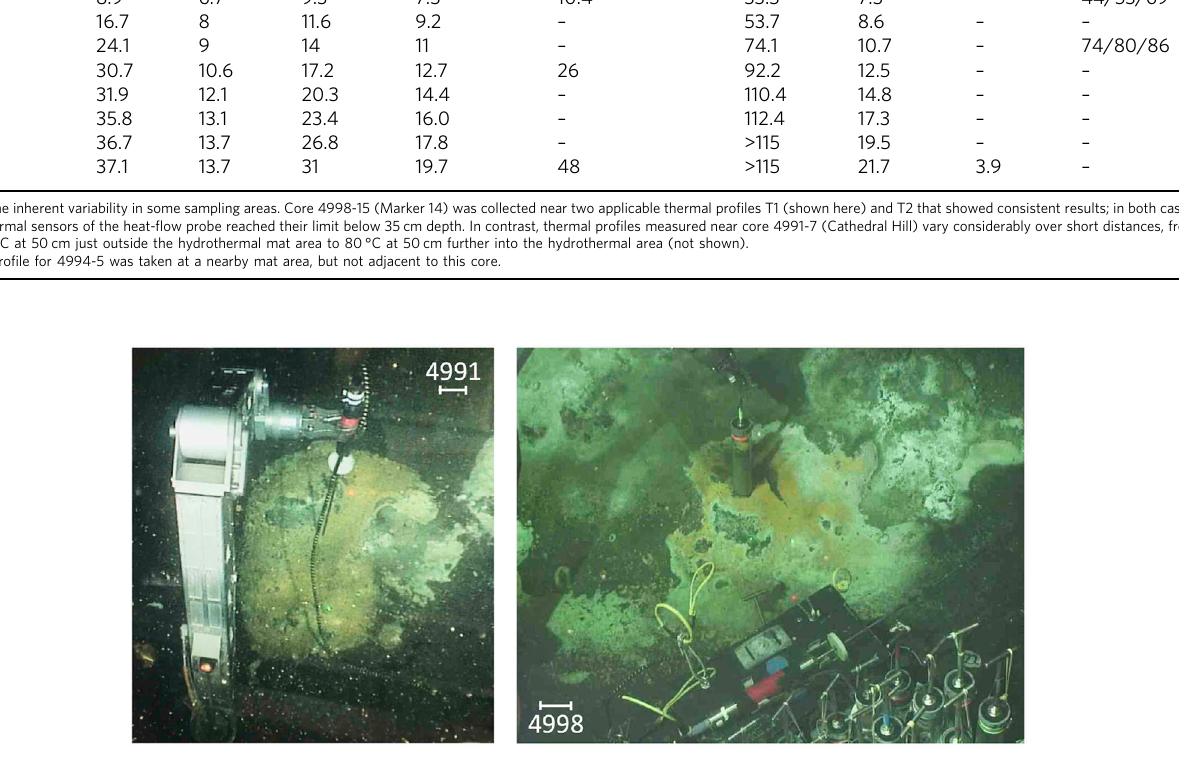
Fig. 1 Hydrothermal sediment sampling sites for cores 4991-7 (Cathedral Hill) and 4998-15 (Marker 14 area). The Cathedral Hill site (4991) and Marker 14 (4998) sites are covered with white, yellow and orange mats of sulfur-oxidizing bacterial mats ( Beggiatoaceae ). The two sites differ by temperature gradient. Scale bars are 10 cm based on Alvin ’ s laser beam scaler and the diameter of Alvin pushcores. Courtesy of Andreas Teske, U. North Carolina, Chapel Hill/NSF/AUV Sentry /2016 ©Woods Hole Oceanographic